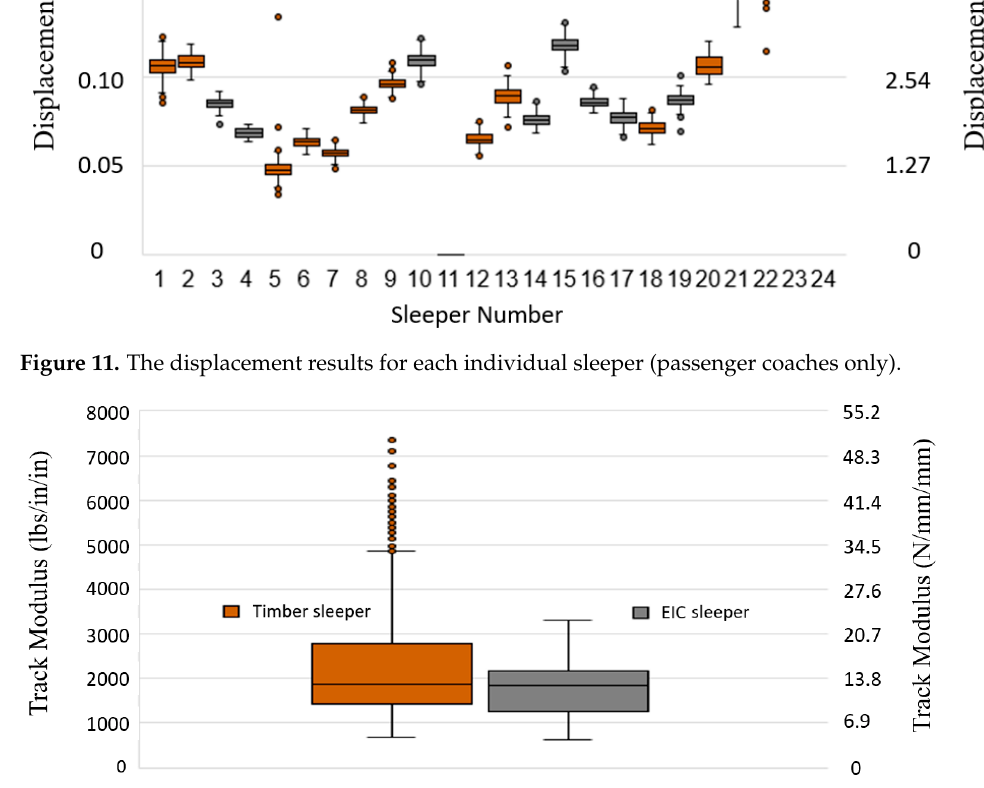
Figure 11. The displacement results for each individual sleeper (passenger coaches only).